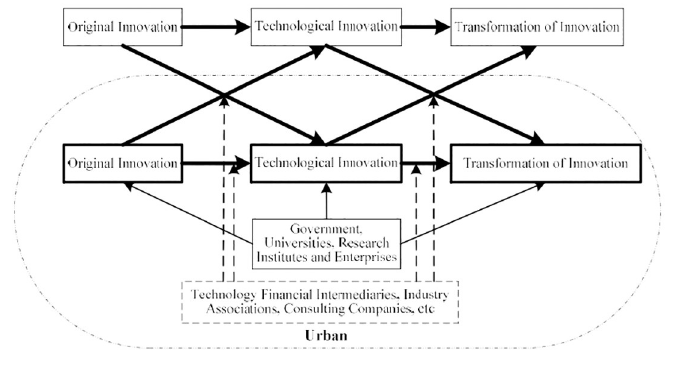
Fig 2. Construction of the